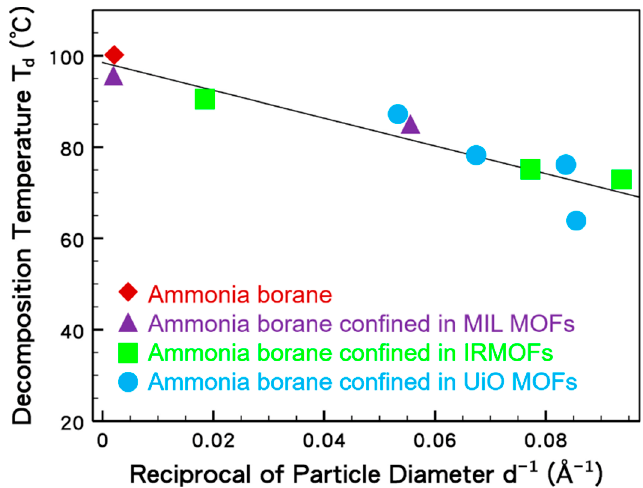
Figure 16. Peaked temperature of decomposition (T d ) of ammonia borane in a pristine state, confined in MIL MOFs, IRMOFs and UiO MOFs, as a function of the reciprocal particle size of ammonia borane particle sizes. Reprinted with permission from ref. [274]. Copyright 2017 American Chemical Society.